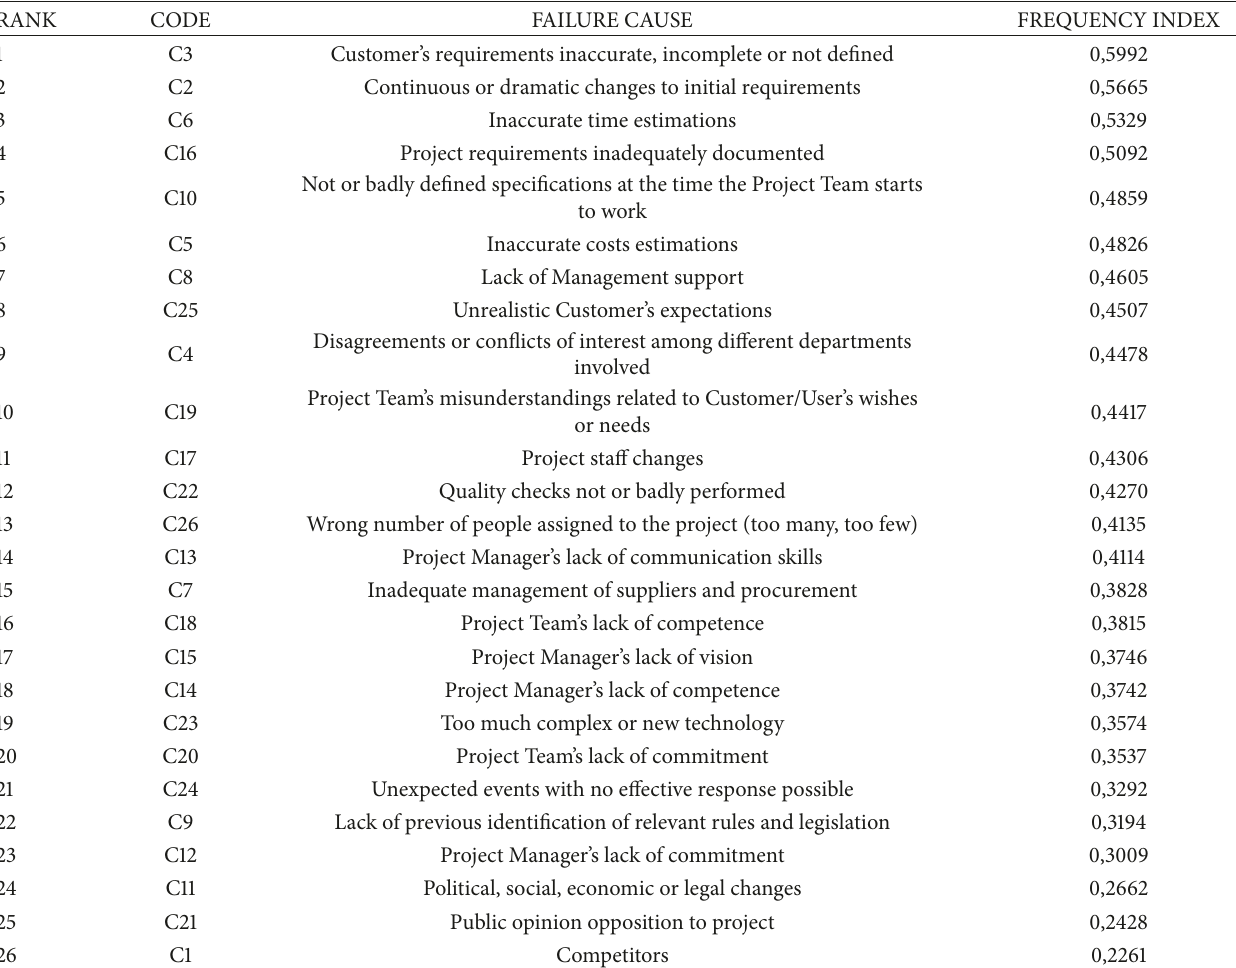
Table 7: Summary of